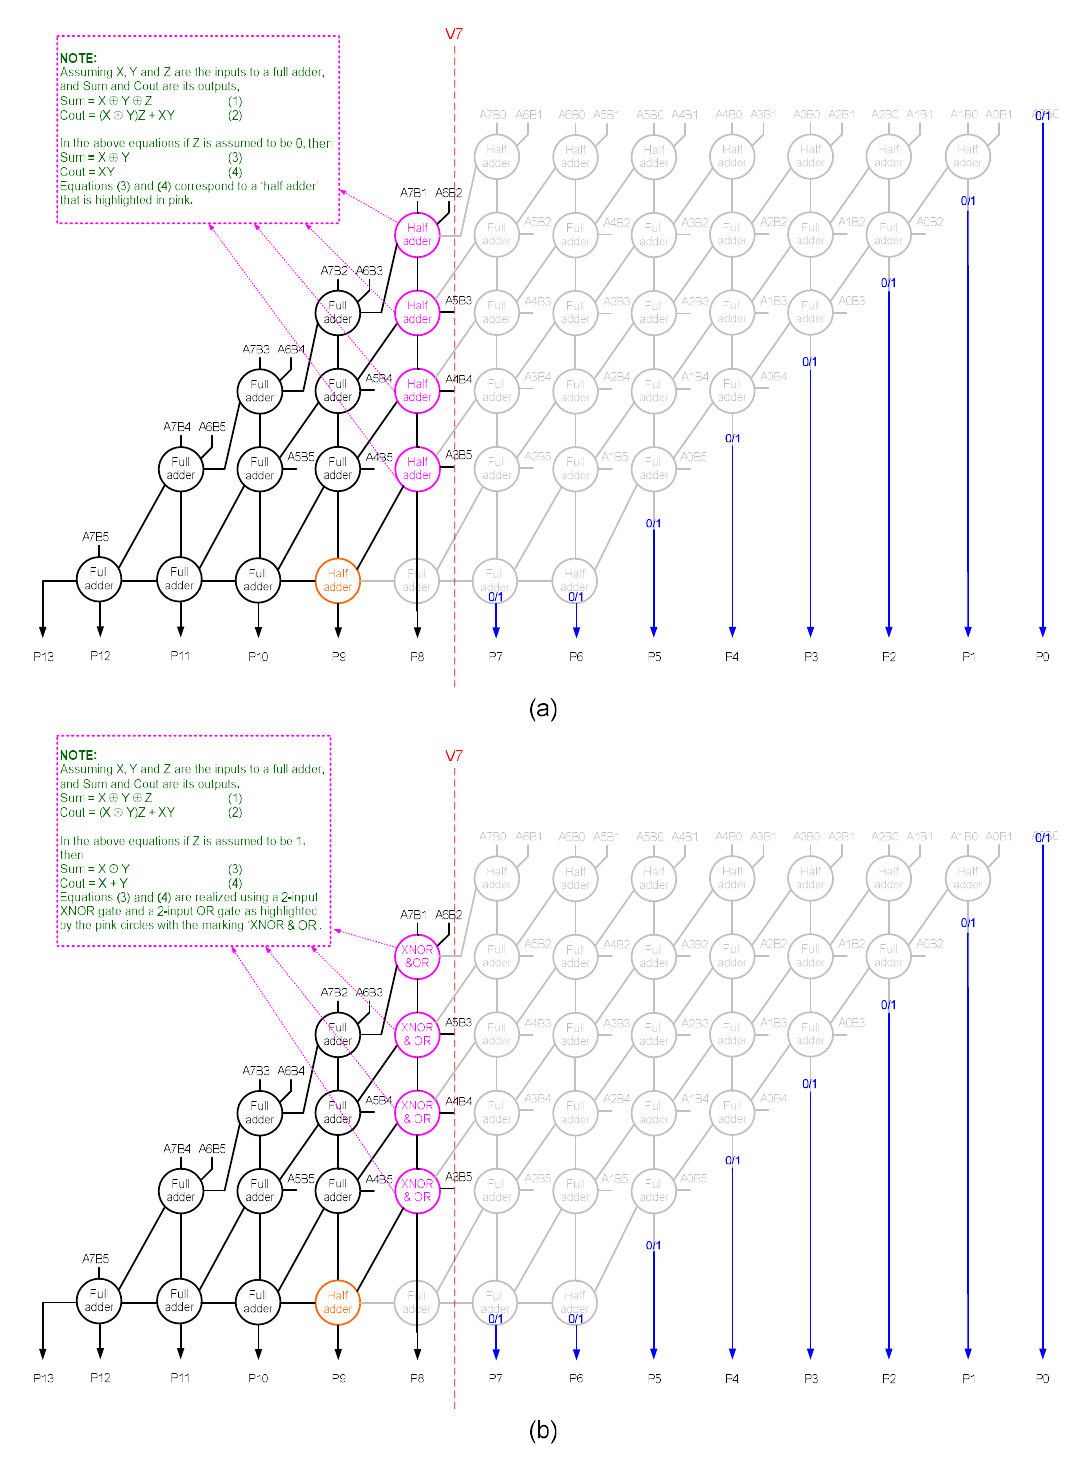
Figure 4. Logic optimization of an approximate array multiplier (obtained through vertical cut V7) based on the assignment of: (a) A 0 input given to the full adders highlighted in pink in the correct Figure 3(a); (b) A 1 input given to the full adders highlighted in pink in the correct Figure 3(a).